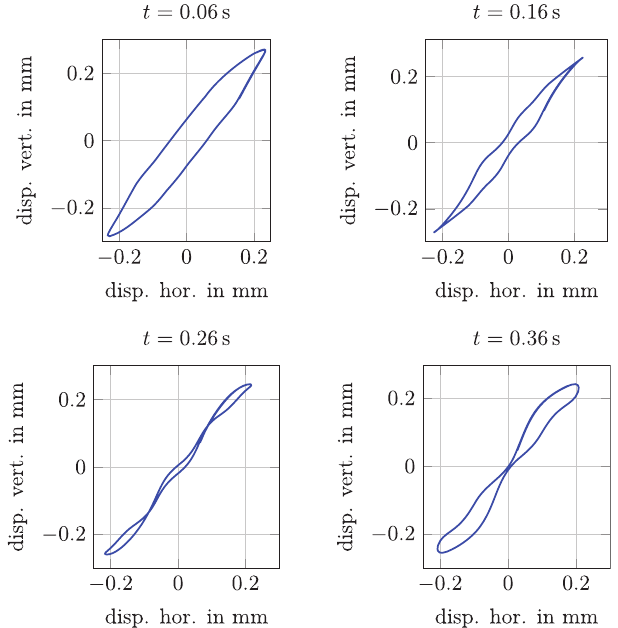
Figure 13. Transient development of the simulated orbit diagram at four points in time.